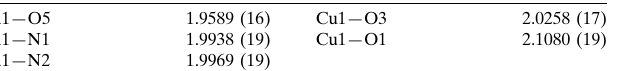
Selected bond lengths (A˚ ).